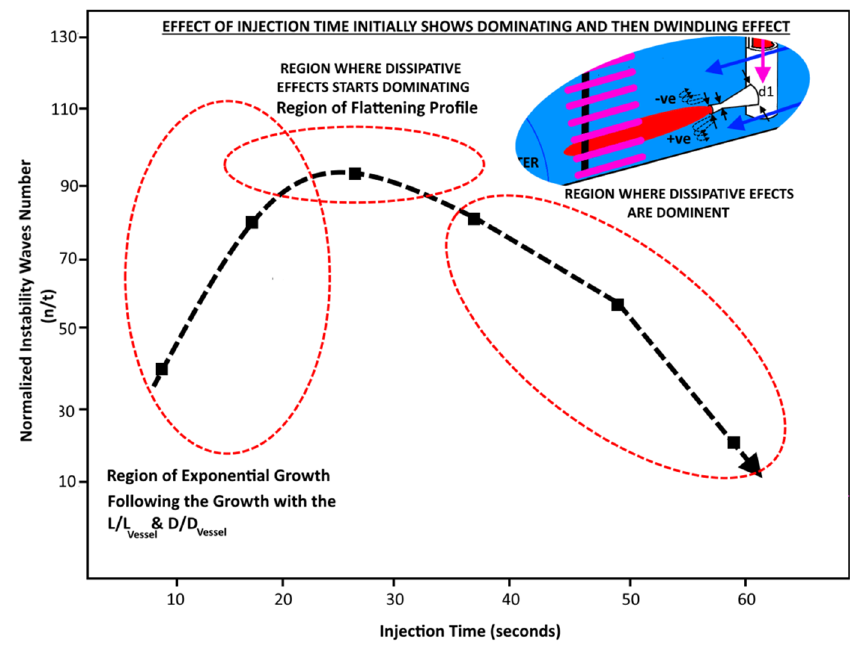
Figure 3. Effect of injection time on normalized instability wave numbers.